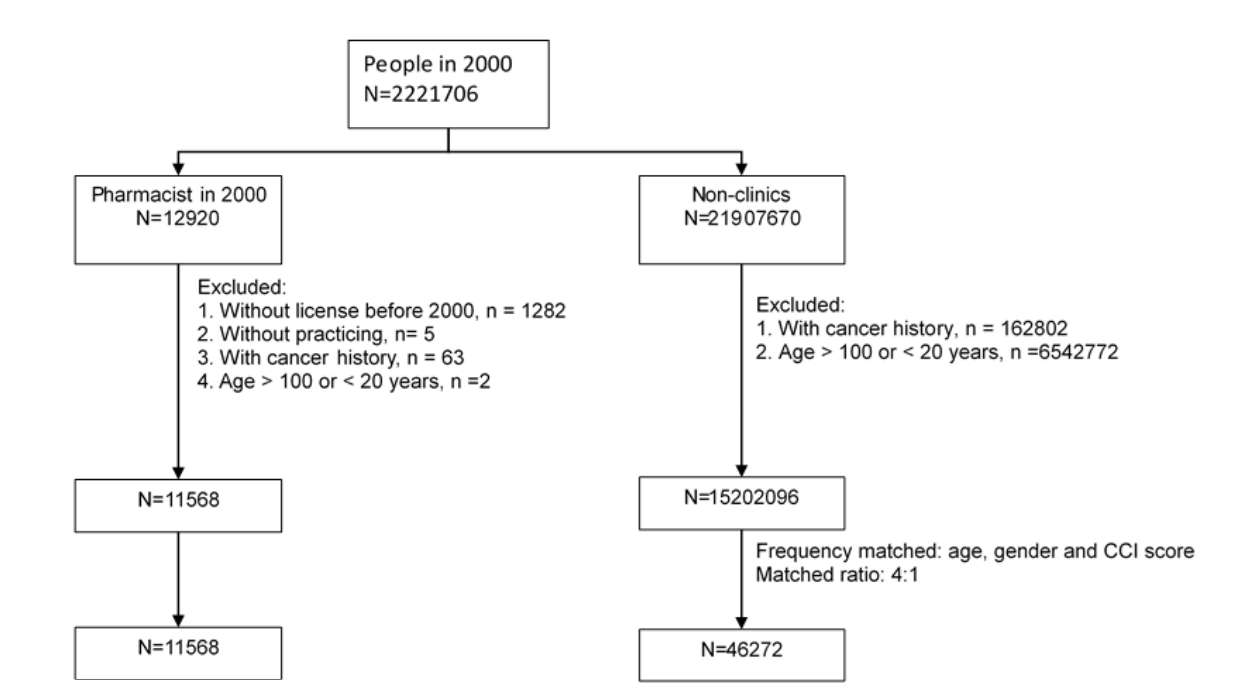
Figure 1. Flowchart showing the selection of the study population.